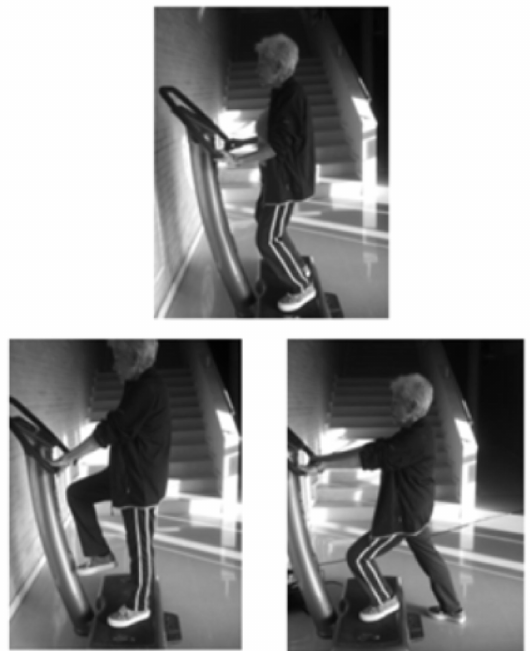
Figure 1. Example of dynamic exercises performed on the vibrating